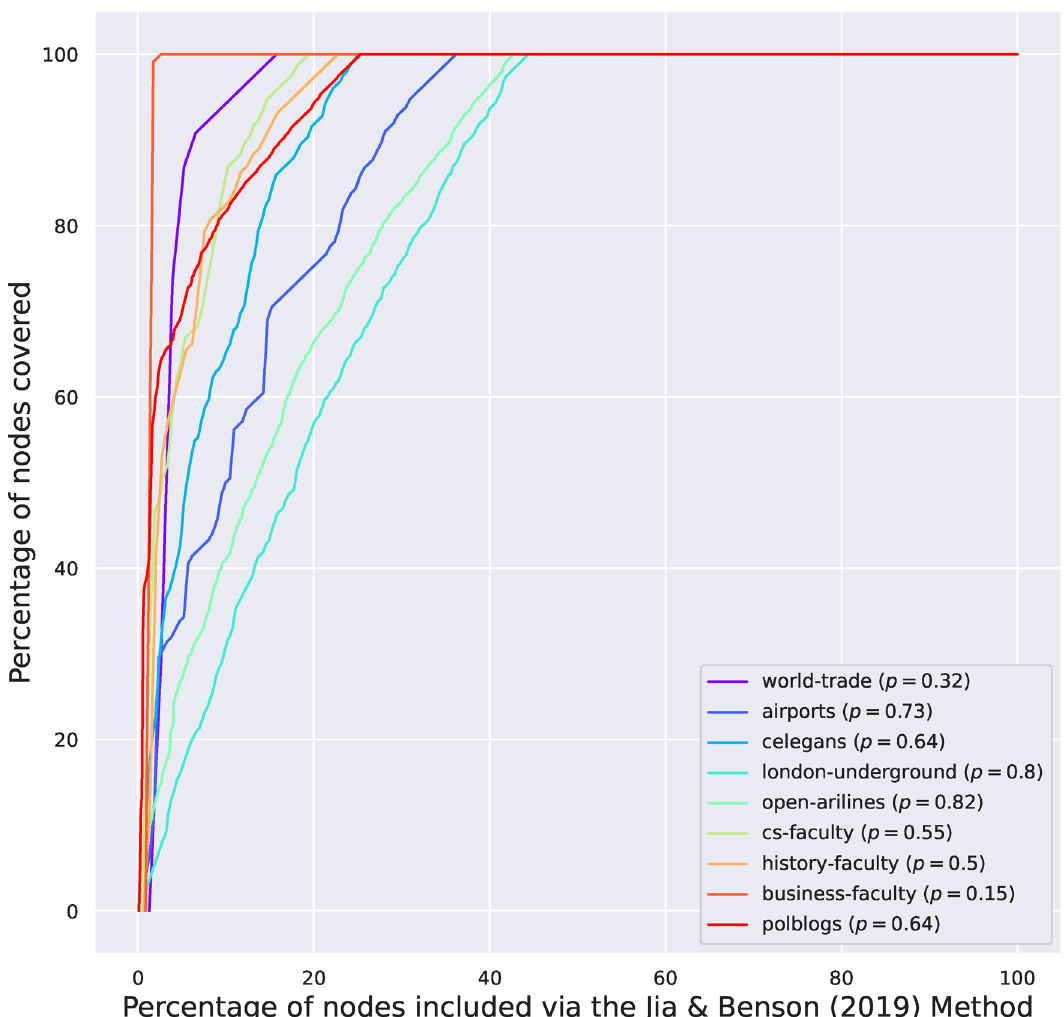
Figure 5. Domination Curve by fitting the model of Jia and Benson 8 on spatial data and the logistic CP model otherwise. Source code to reproduce the Figure can be found in Ref. 33